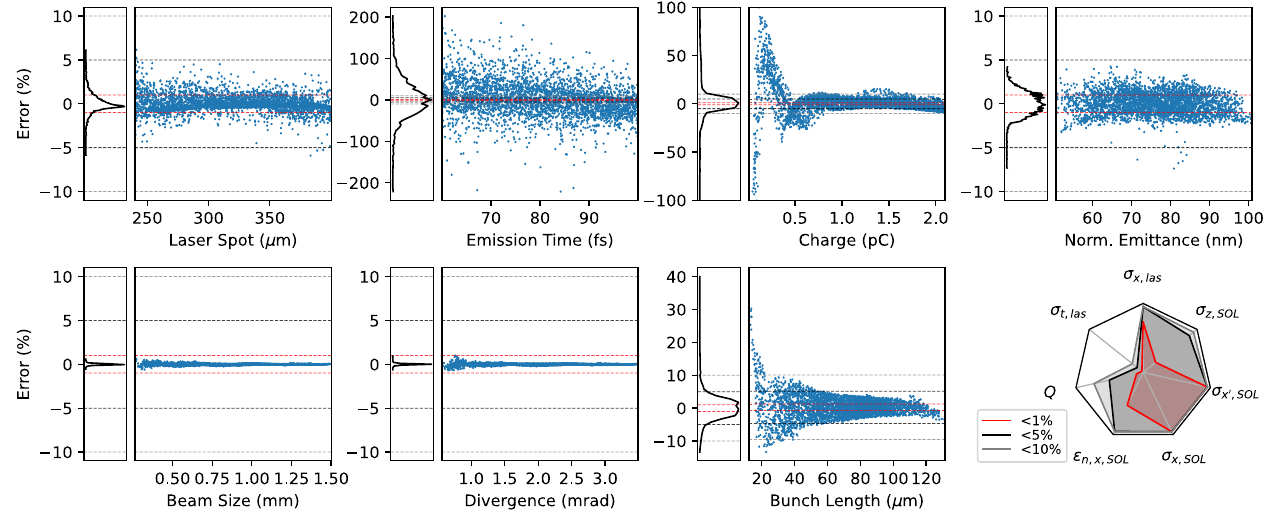
FIG. 6. Relative error distributions for all verification datasets and label components. The last plot is a radar plot showing the percentage of datasets within a 1% (red), 5% (black), and 10% (gray) relative error interval, respectively. The dashed lines in the distribution plots refer to the same error intervals. Q : Bunch charge, σ t; : Emission time, σ x; : Laser spot size, σ z; : Bunch length at las las SOL the solenoid, σ x 0 ; : Divergence at the solenoid, σ x; : Beam size at the solenoid, ε : Normalized emittance at the solenoid. SOL SOL n ;x; SOL